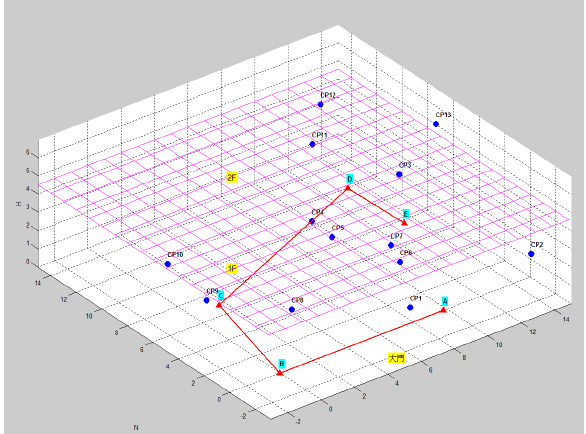
Figure 11(a). Distribution of the control point (Top view).